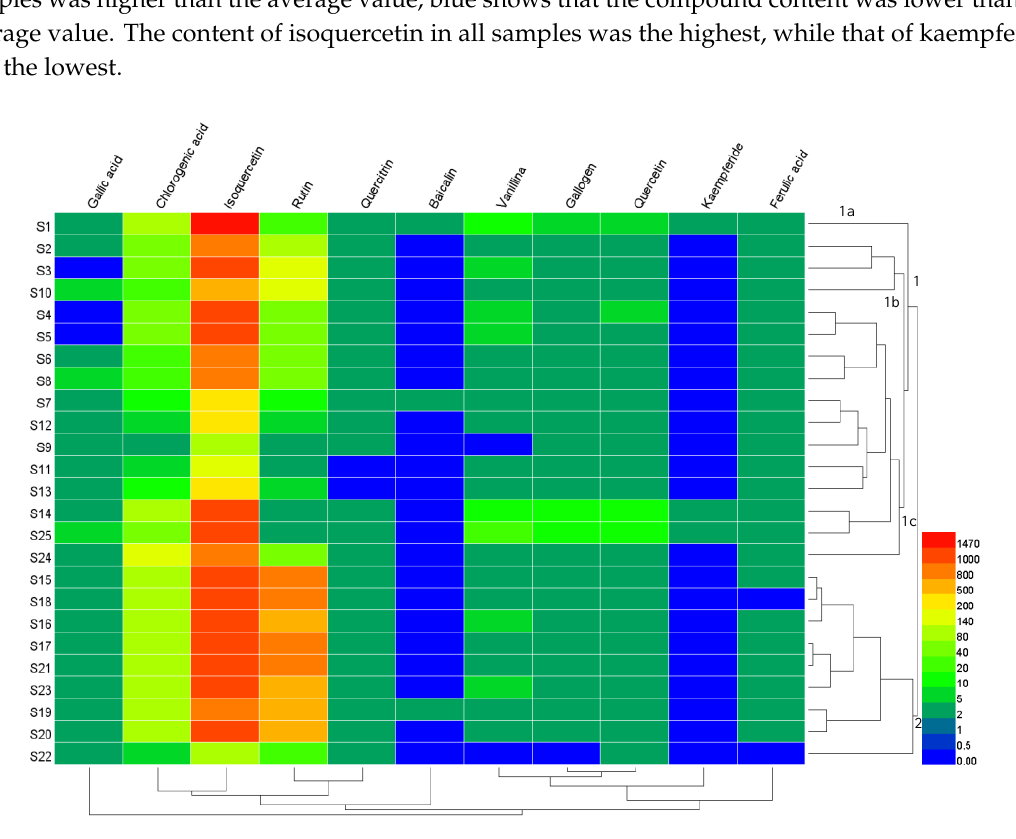
Figure 3. The heatmap of content di ff erences of samples, as well as a dendrogram showing the hierarchical cluster analysis (HCA) results for the concentrations of the 11 components in 25 batches of samples.